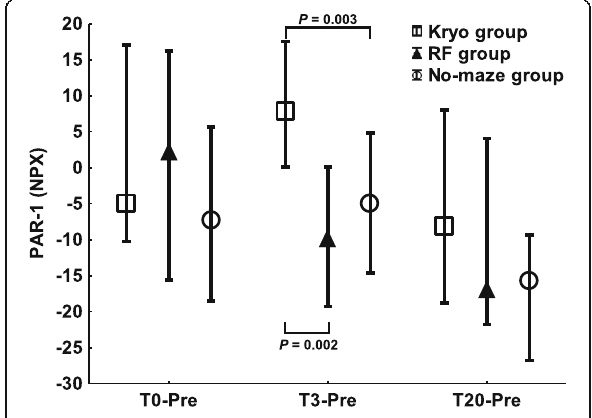
Fig. 3 Protease-activated receptor 1 (PAR-1) changes from preoperatively (Preop) to the end of surgery (T0), and 3 h (T3) and 20 h (T20) postoperatively displayed as median and 25th to 75th percentile in the three study groups. P values indicate the significance level at post hoc comparisons of mean ranks of pairs of groups when multiple comparisons of mean ranks for all groups, Kruskal-Wallis test showed significance. NPX: Normalized Protein Expression